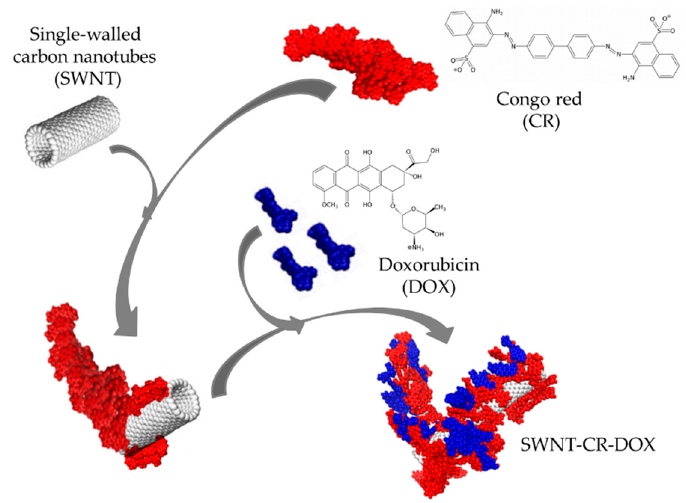
Figure 1. Schematic model of Congo red (CR) interaction with single-walled carbon nanotubes (SWNT) and intercalation of guest compound (doxorubicin, DOX) into ribbon-like structure of Congo red (CR).